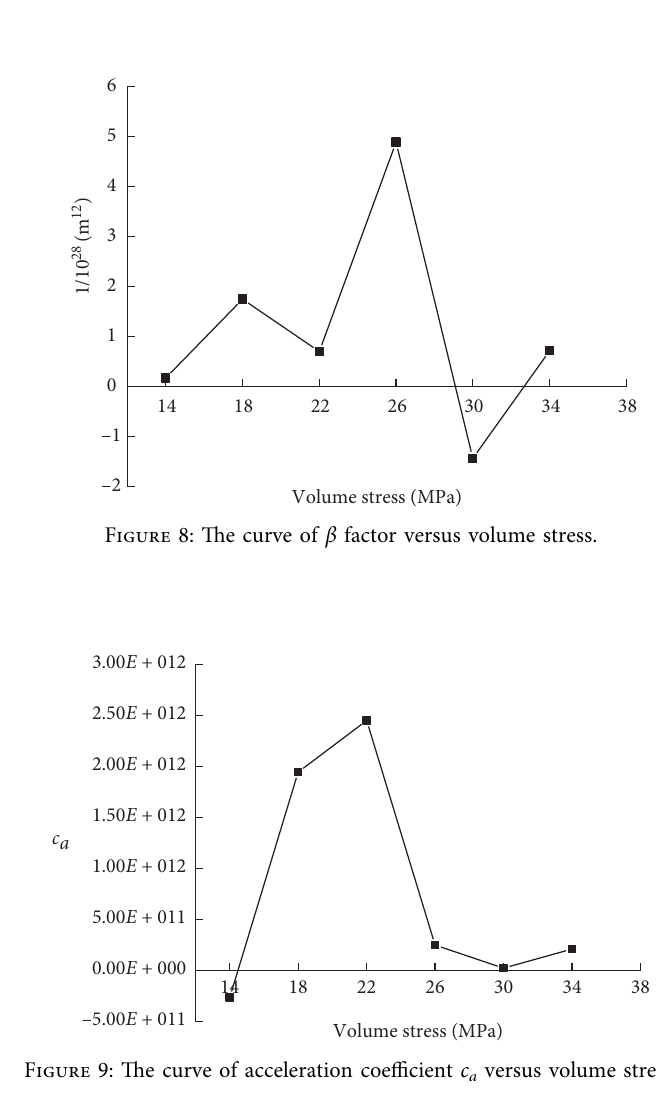
a versus volume